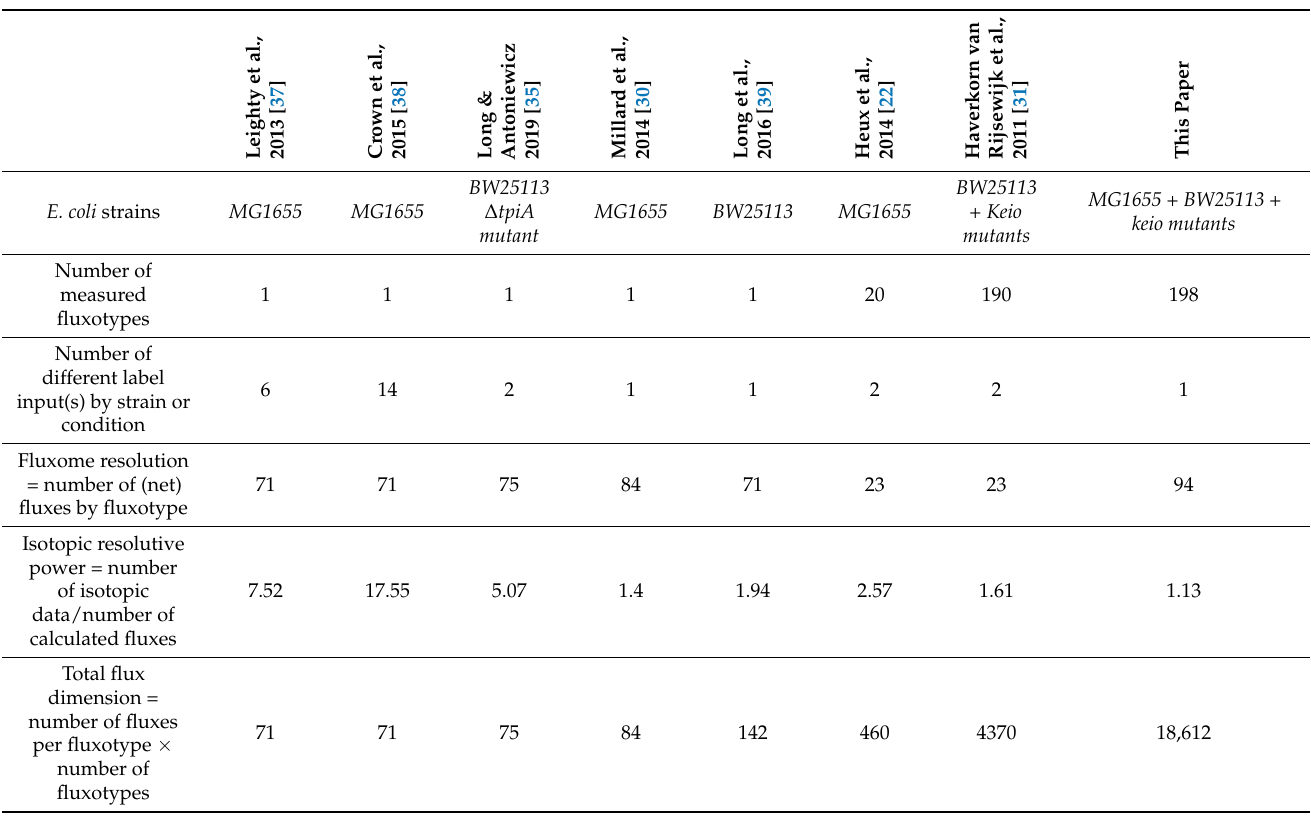
Table 1. Evaluation of data size and quality in HT fluxomics investigations. The overall flux precision is the median RSD (relative standard deviation) calculated for all fluxes measured in each of the studied conditions, as given in the supplementary data of the cited studies. The overall pathway precision was calculated similarly by grouping the RSDs according to the metabolic pathways considered. The flux RSDs considered in these calculations were obtained by sensitivity analysis (S.A.) or by calculating classical standard deviations on the mean values of fluxes obtained when biological replicates were produced (as in this